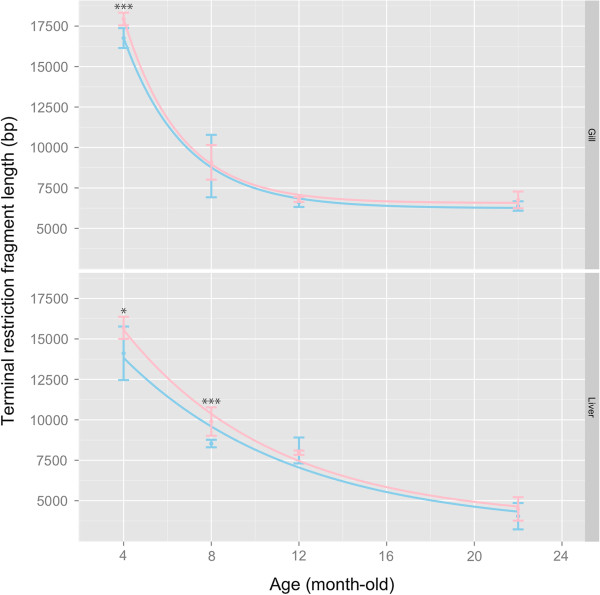
Change of telomere length, as represented by the size of terminal restriction fragment (TRF; in bp), in male (blue) and female (pink) O. latipes during aging (upper: gill; lower: liver). Shortening of organ TRF length across age in each sex was modeled by an exponential decay curve (see Materials and Methods). Error bars are standard error of mean (SEM). Asterisk indicates significant difference in TRF length between sexes at specific age: * = p < 0.05, *** = p < 0.001 after FDR-adjustment.